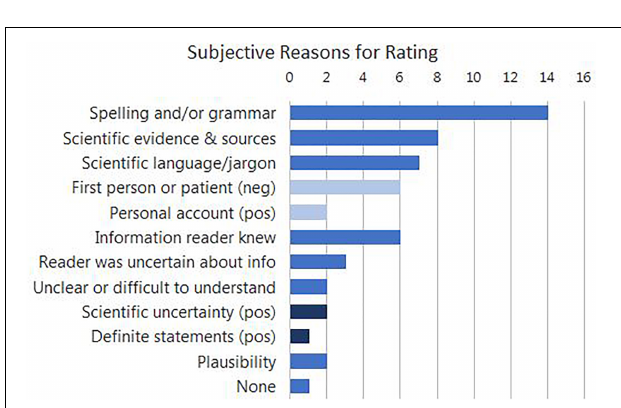
FIGURE 1 | Cumulative probabilities of trustworthiness ratings for all stimulus paragraphs combined. Position of lines toward the lower right of the plot indicates higher trustworthiness compared to lines positioned to the upper left.